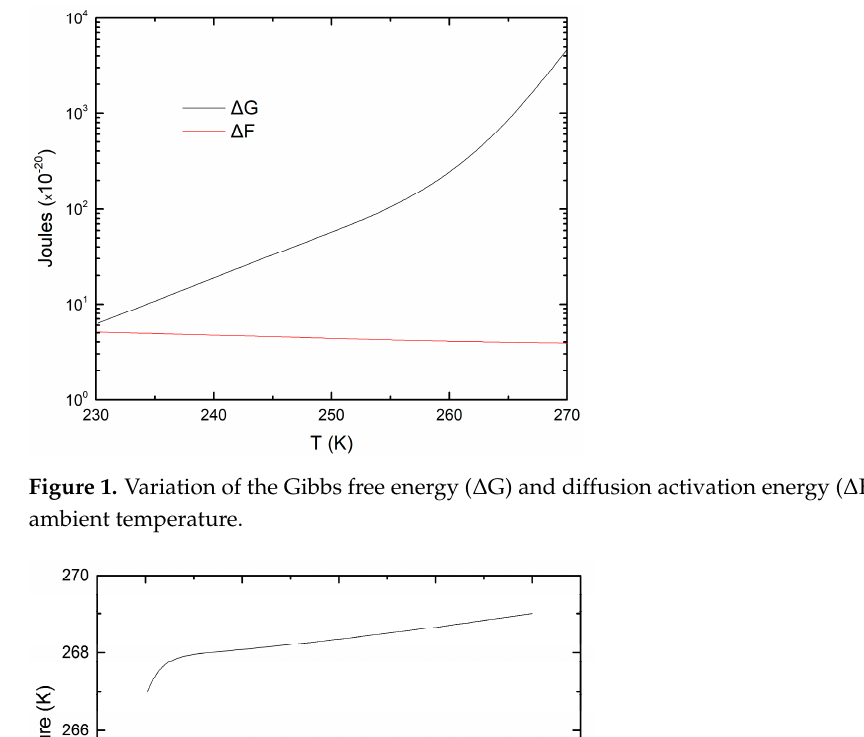
Figure 1. Variation of the Gibbs free energy ( Δ G) and diffusion activation energy ( Δ F) (Joules) with ambient temperature.